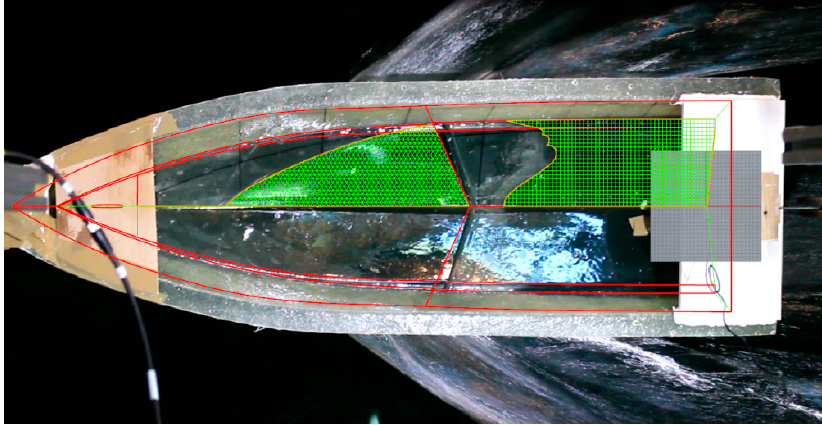
Figure 12. The experimental wetted surface evaluation using recorded video frame @ Fr = 1.151.